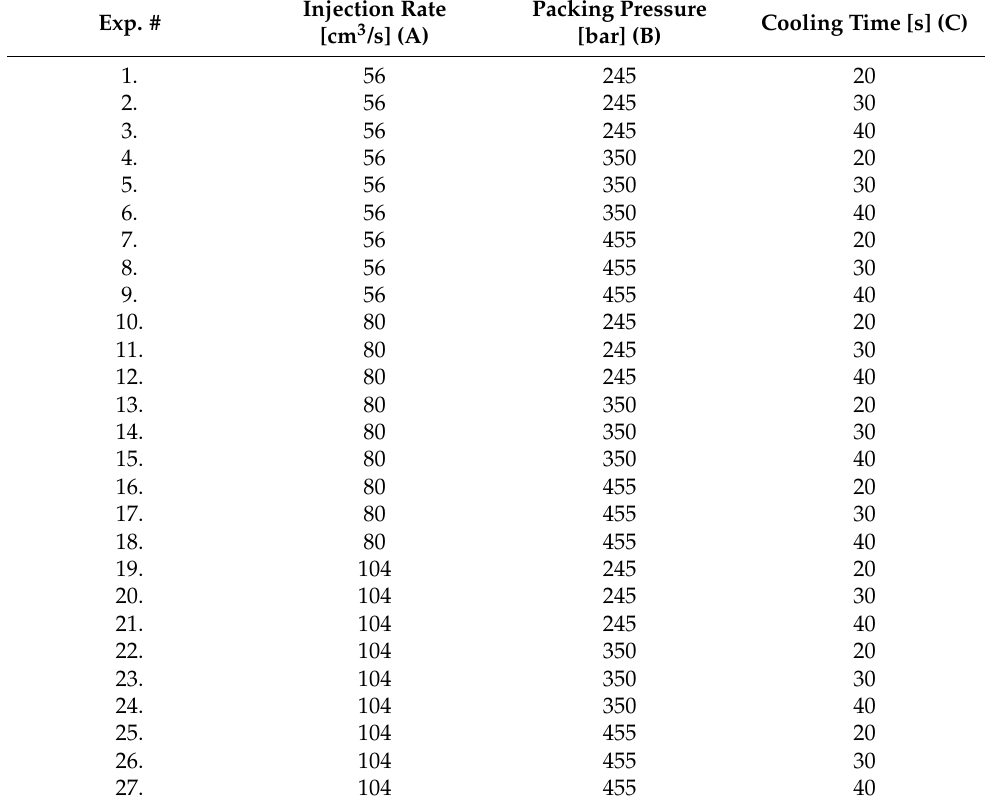
Table 5. Experimental design with 27